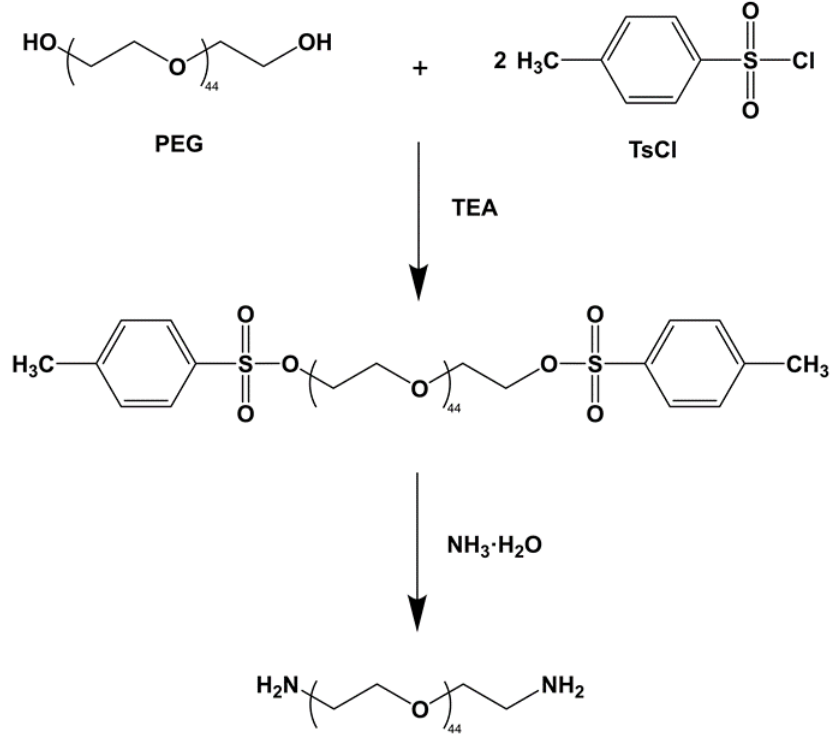
Figure 1. The synthesis of polyoxyethylene